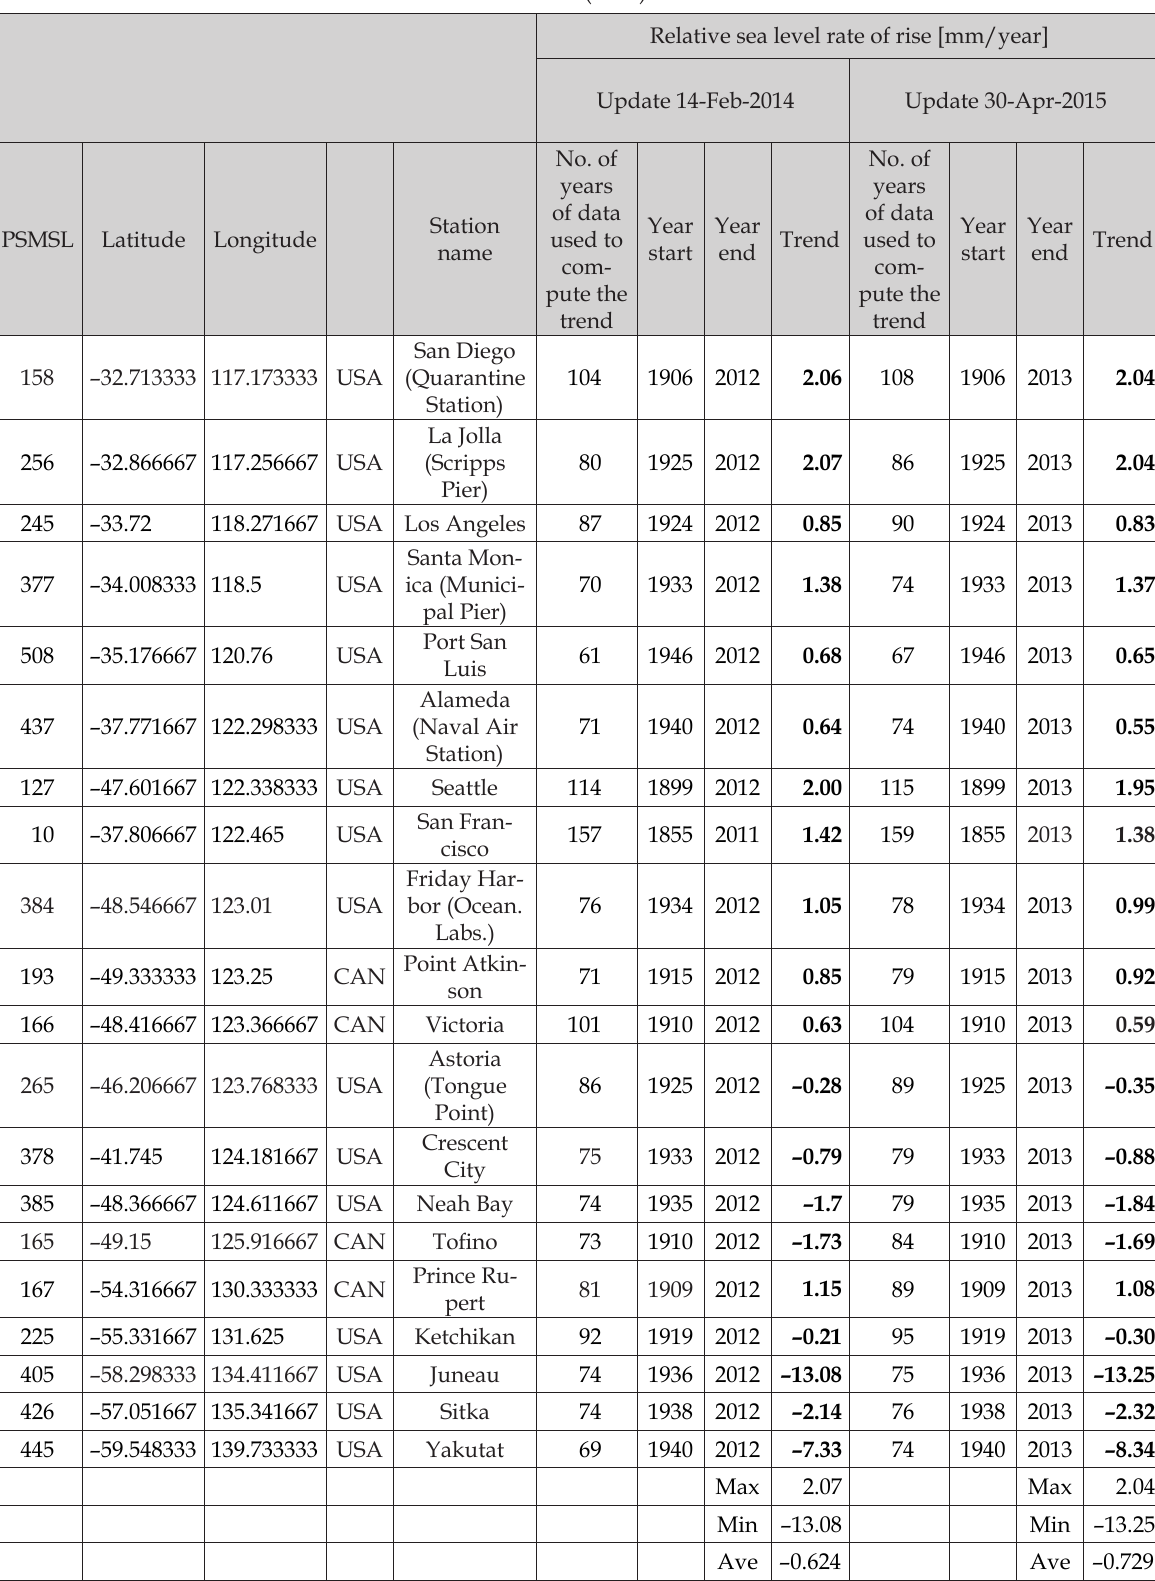
Table 1. Relative sea level velocities of the PSMSL tide gauges of the West Coast of the US including Alaska and Canada having more than 60 years of recorded data (updates 30-Apr-2015 and 14-Feb-2014). Data are